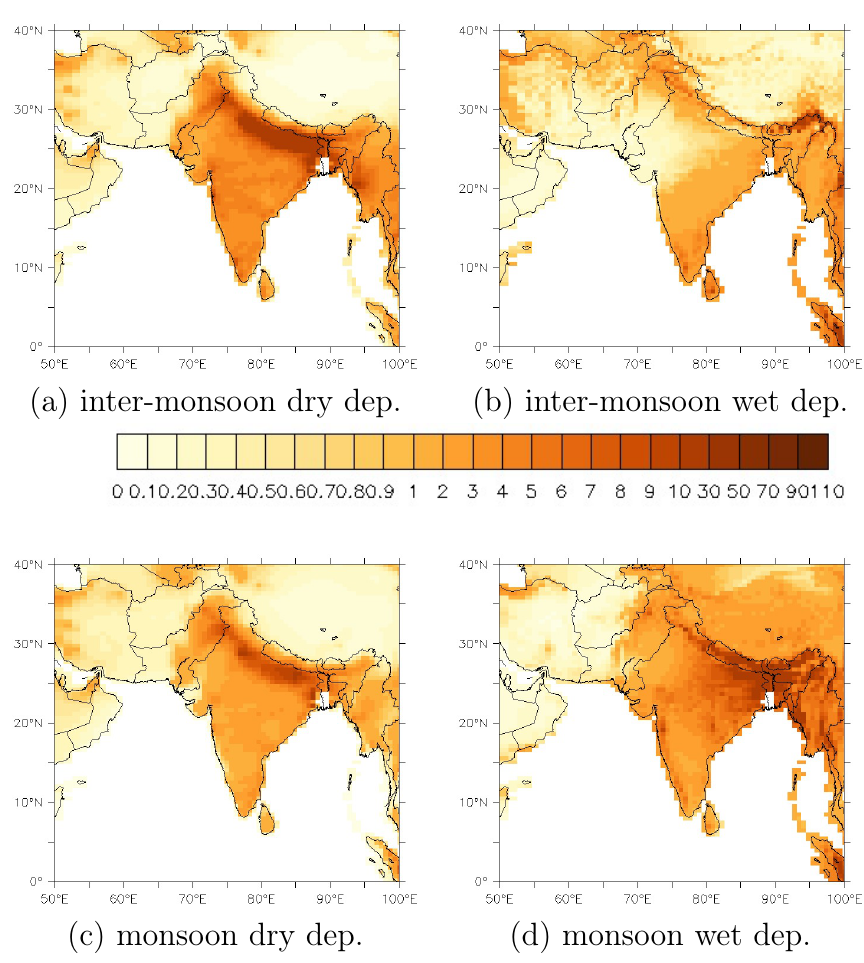
Fig. 2. BC deposition (mgm − 2 month − 1 ) modelled over the Indian subcontinent averaged over 1998–2008. (a) Inter-monsoon (ONDJF- MAM) dry-deposited BC. (b) Inter-monsoon wet-deposited BC. (c) Monsoon (JJAS) dry-deposited BC. (d) Monsoon wet-deposited BC. LMDZ simulation based on a stretched grid reaching a resolution of ∼ 50km over the